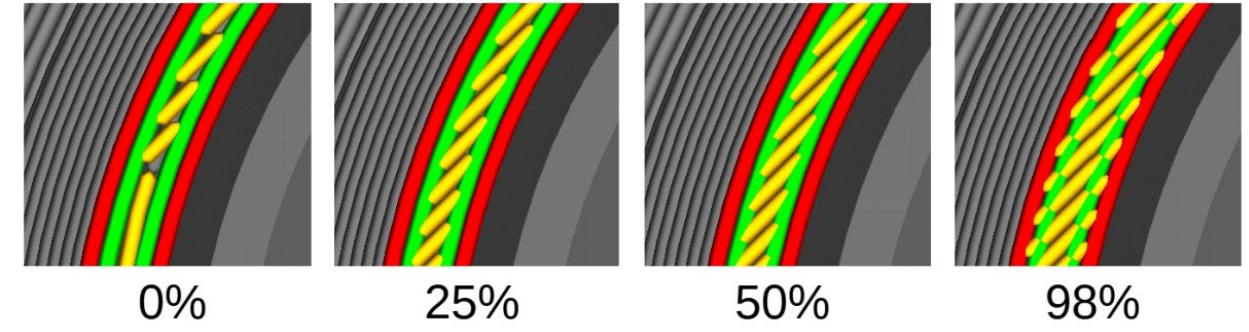
Figure 2. Renderings from Cura Lulzbot showing difference in G-code for overlap percentages. The outer shell is shown in red and the inner shell is shown in green; yellow paths rep-resent the infill lines in the 3D print.